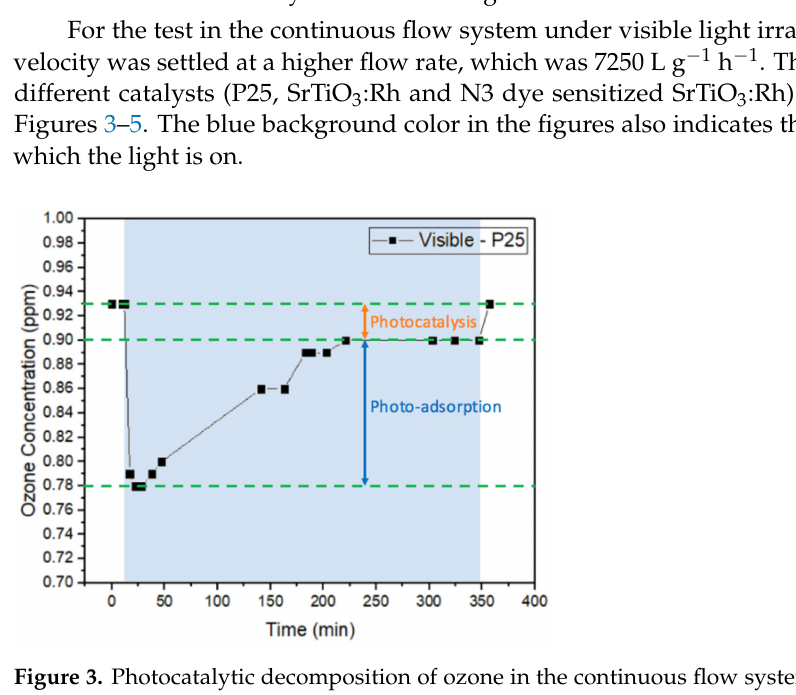
Figure 3. Photocatalytic decomposition of ozone in the continuous flow system by P25 under the halogen lamp (OSRAM, 50 W, broad band, with 400–500 nm bandpass filter).